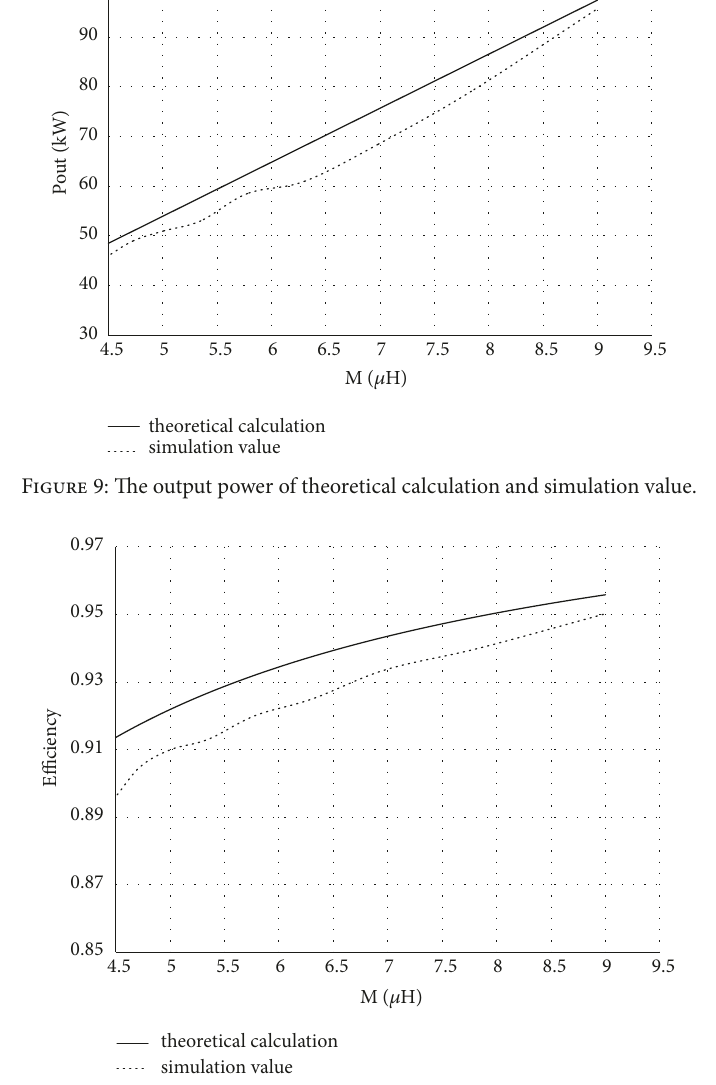
Figure 10: The transmission efficiency of theoretical calculation and simulation value.